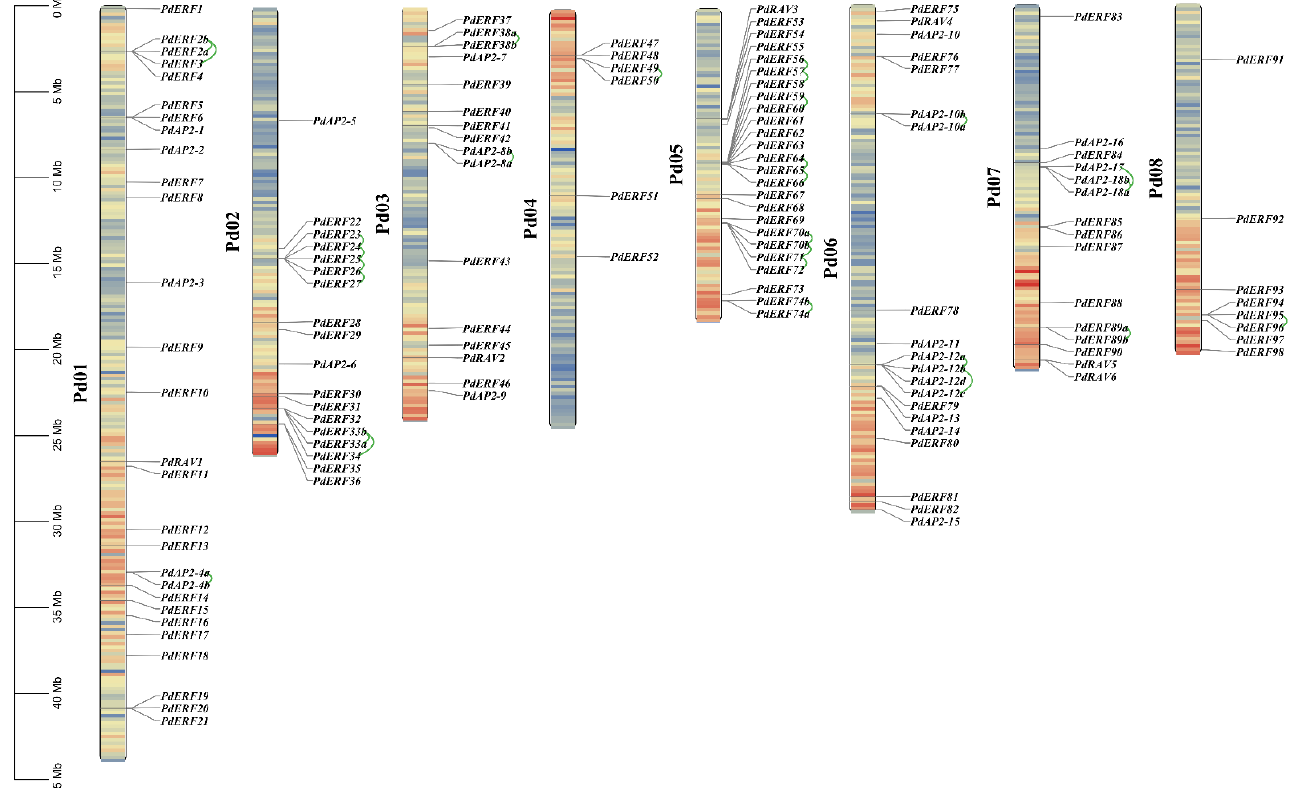
Figure 3. Chromosome localization of almond PdAP2/ERF family members. The green lines show tandem duplicated genes. The scale on the left shows the chromosome length information, and the chromosome names are listed on the right. The blue regions in the chromosome segments represent low gene density, and the red regions represent high gene density.